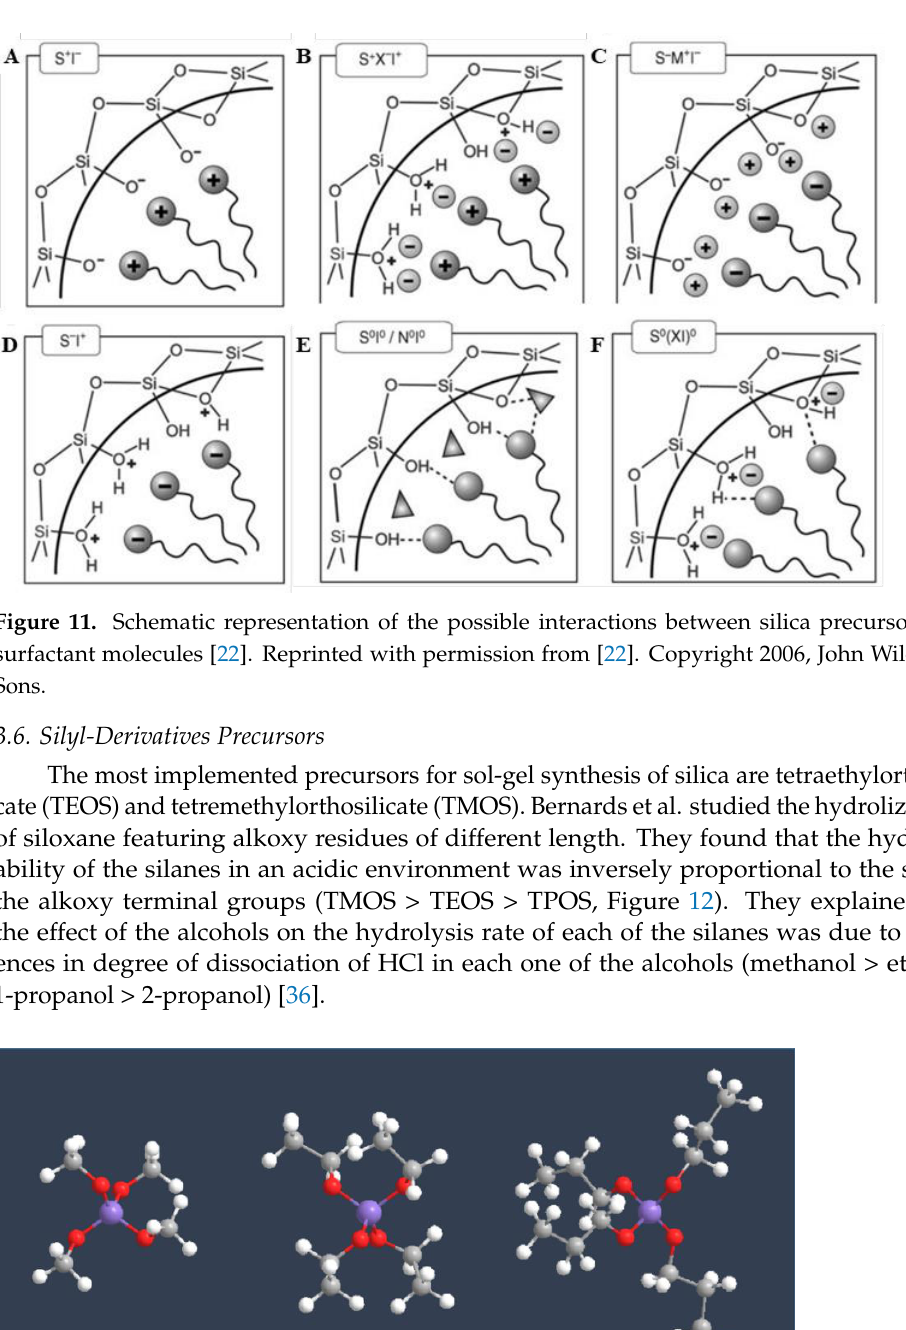
Table 1. Families of hybrid catalysts described in this review article.